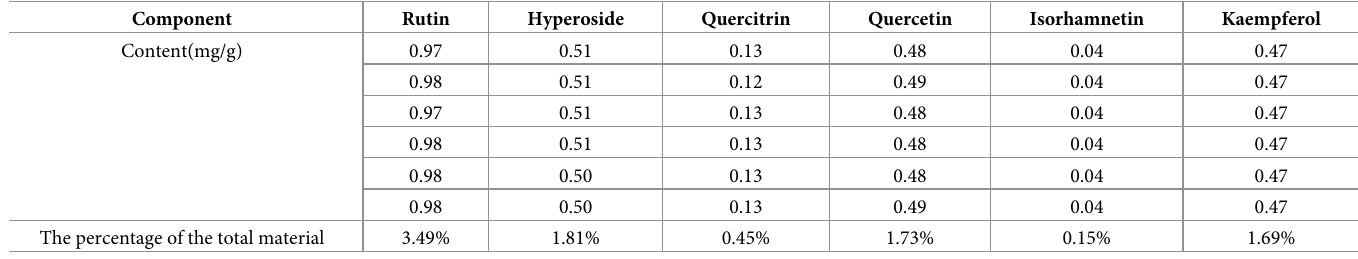
Table 3. The content of active components of